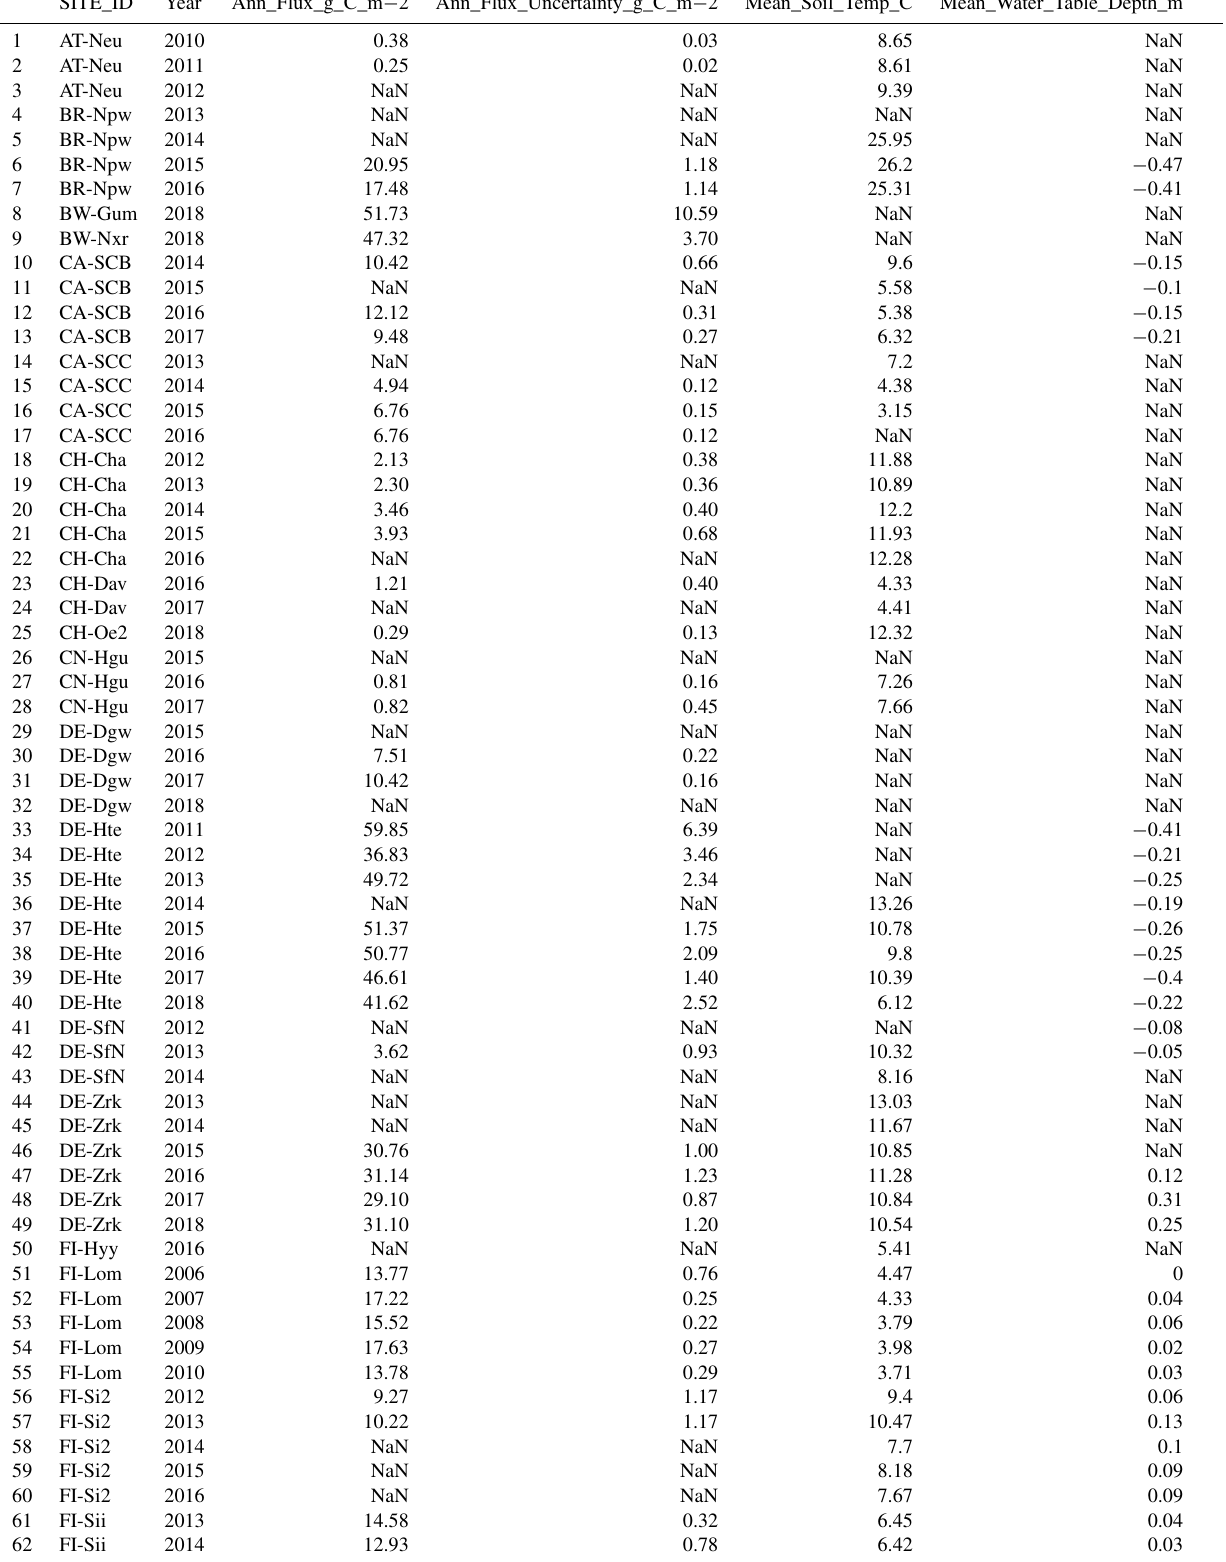
Table B2. Annual methane flux sum and uncertainty, annual mean soil temperature, and annual mean water table depth. Column headers are explained after the